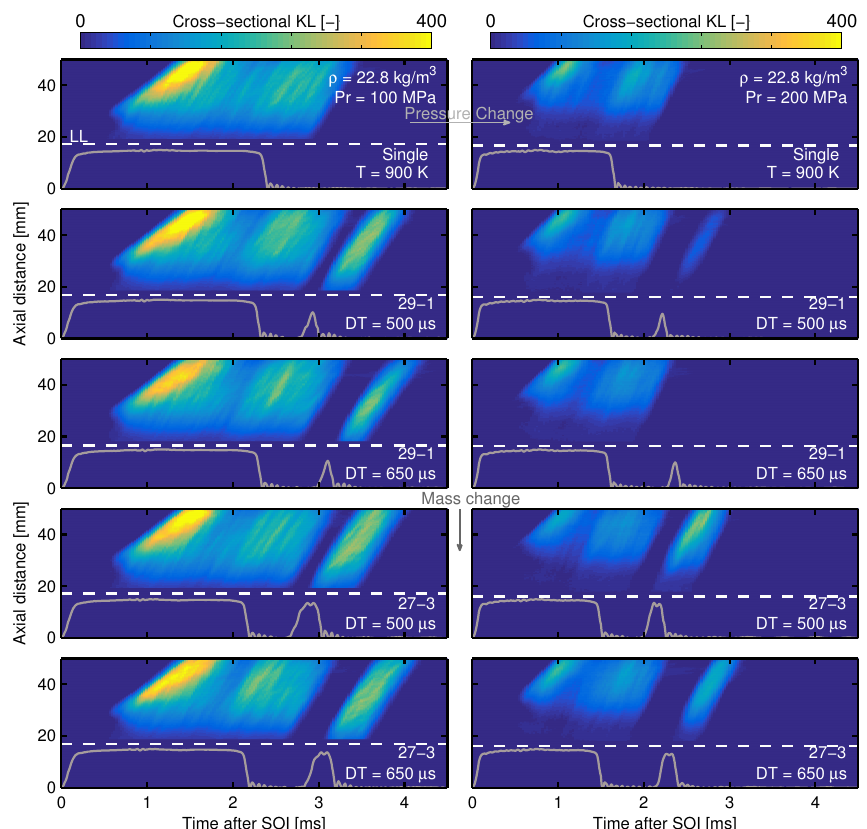
Figure 16. Evolution of the cross-sectional KL at each axial distance for main-post strategies, for a rail pressure of 100 MPa (left) and 200 MPa (right), a chamber density of 22.8 kg · m − 3 , and temperature of 900 K. The dashed white lines depict the liquid length of the main (horizontal), and start of injection of the post (vertical). Gray arrows represent the direction of the variable changed for